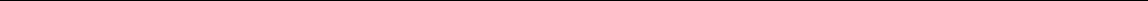
Fig. 9a, mass spectra detected clear mRMA:m 5 C and mRNA: